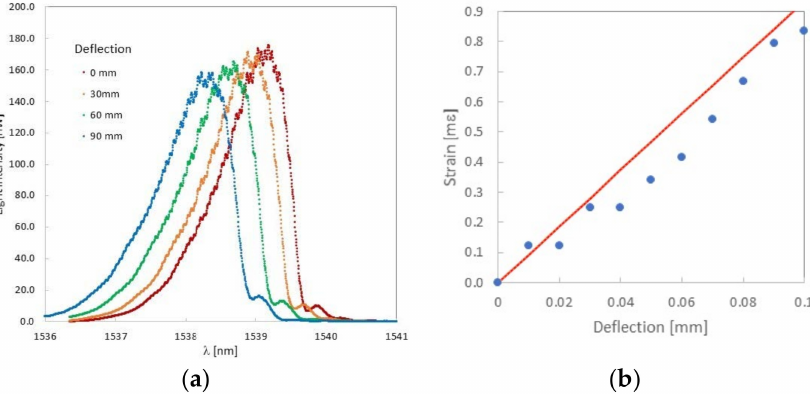
Figure 8. Change of the Bragg wavelength as a function of deflection ( a ) and comparison of the measured strain (modulus) value with the theoretical value ( b ) for a rectangular bar with a thickness of 6 mm.